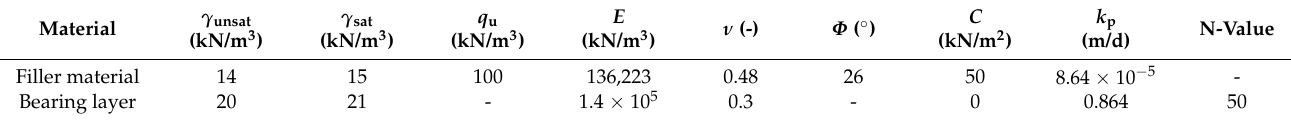
Table 2. Input parameters for the filler material and bearing